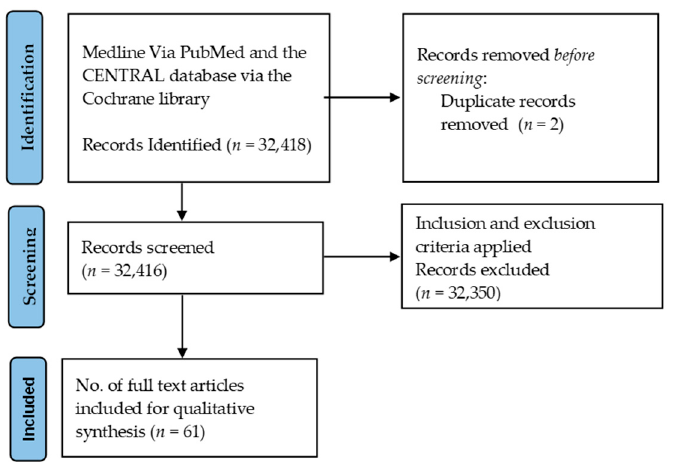
Figure 1. Identification of search strategies for qualitative review synthesis databases and registers on diagnostic gaps in TB